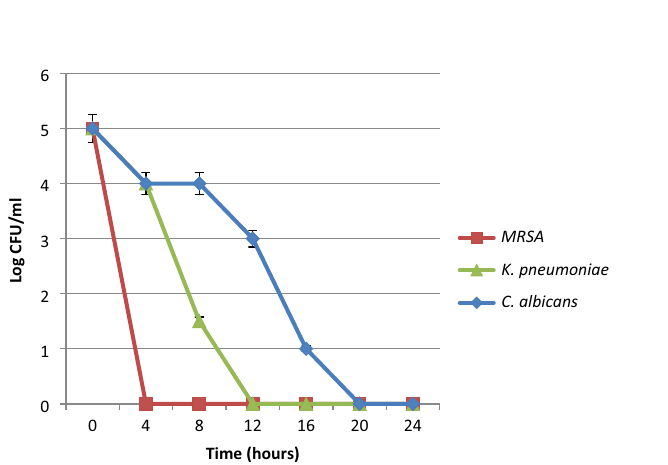
Figure 2. Time lethality curve of the ultra-small Au-NPs against Candida albicans, MRSA and K. pneumonia